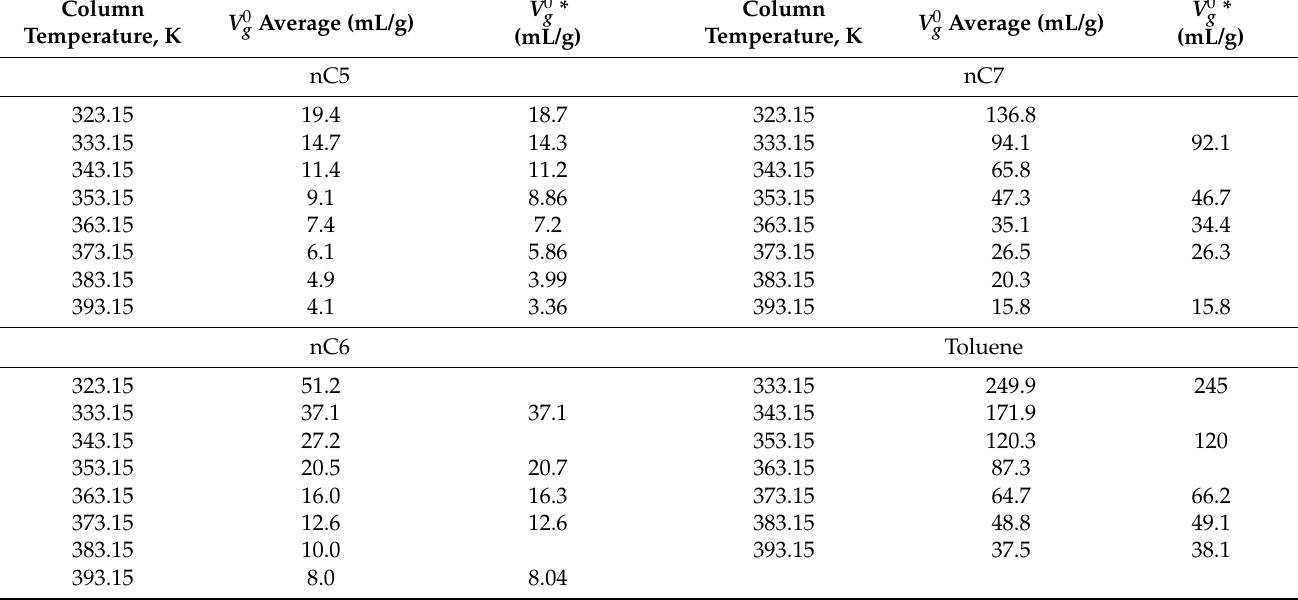
Table 3. Specific retention volume V 0 g comparison between references and the calculated V 0 g .